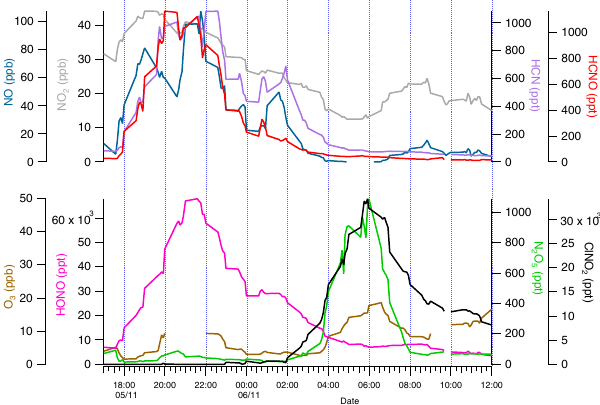
Figure 8. Time series of gases pollutants during Bonfire